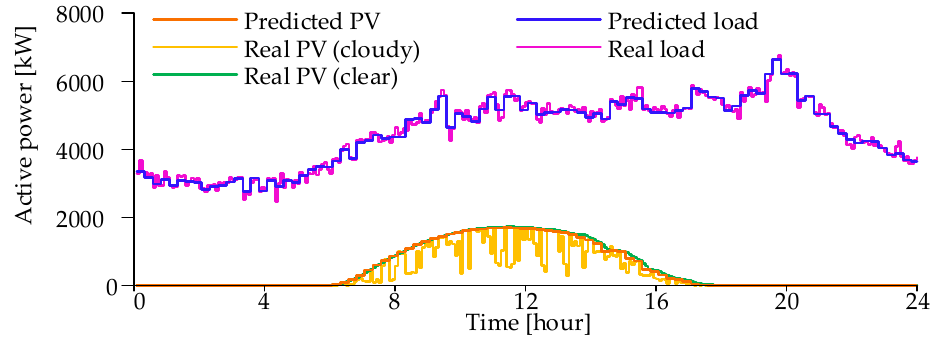
Figure 2. Daily active load and PV generation profiles.